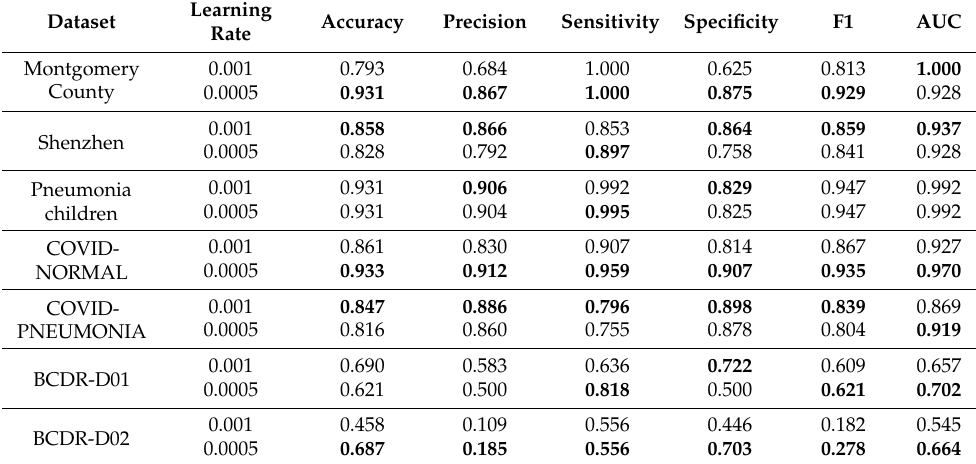
Table 6. Results using Adam optimizer and different learning rates for NanoChest-net.